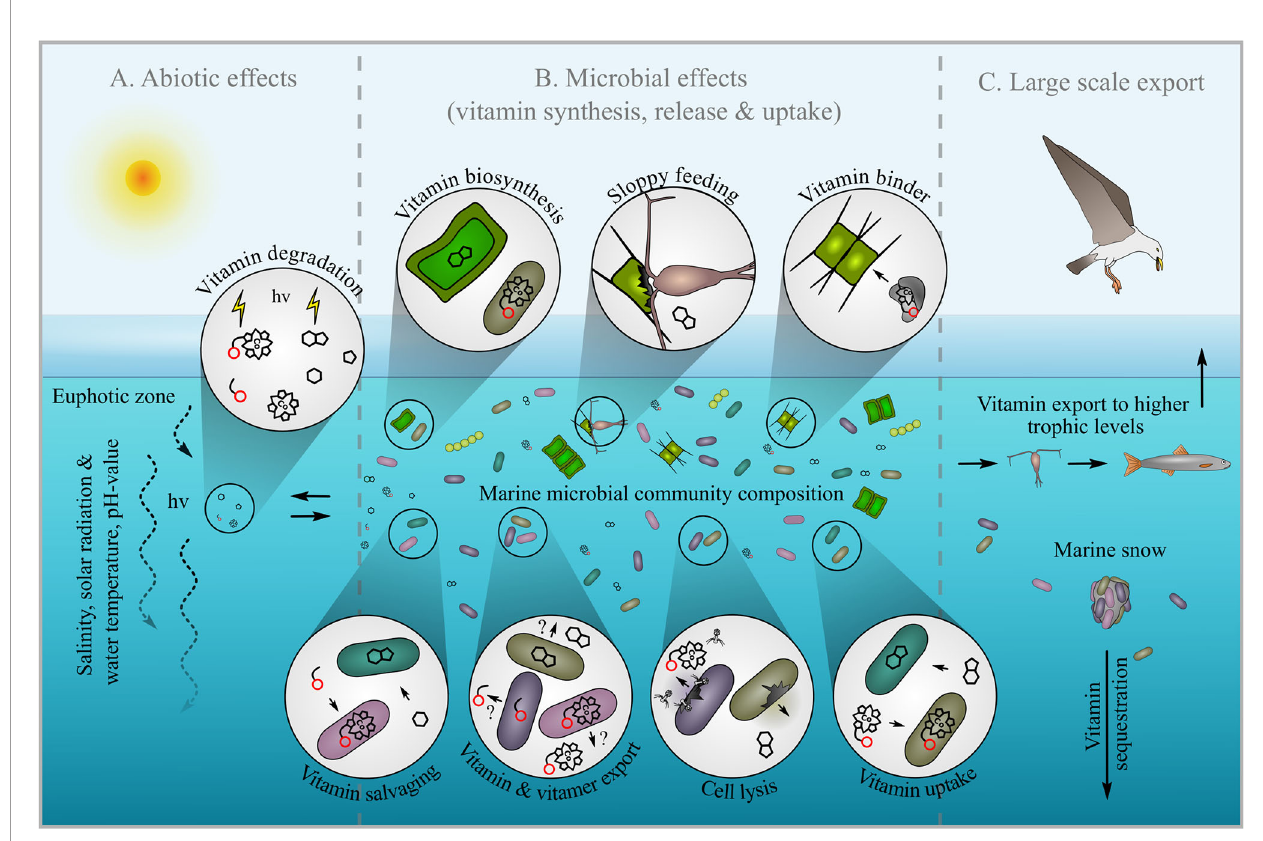
FIGURE 2 | B-vitamin cycle in the pelagic ocean. The left section (A) illustrates abiotic factors that can affect the stability of B-vitamins including salinity, solar radiation, water temperature and pH. Microbial processes describing vitamin synthesis and salvaging as well as vitamin release and uptake are show in the middle section (B) . Potential routes of large-scale B-vitamin export are depicted in the right section including transfer up the marine food web to higher trophic levels and sinking of B-vitamin rich marine snow (C)